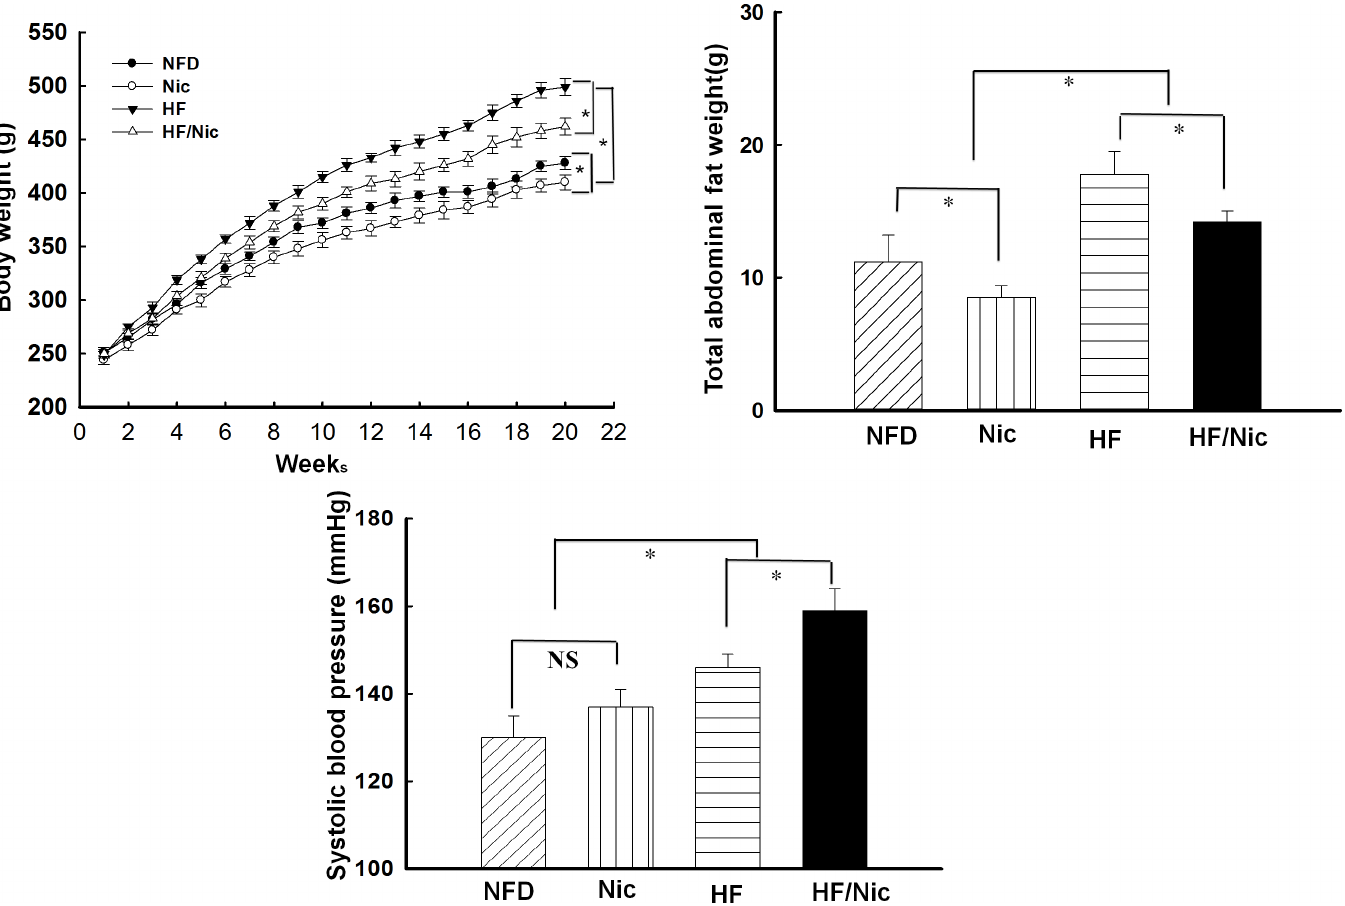
Fig 1. Body weight (A), total abdominal fat weight (B) and systolic blood pressure (SBP, C) in nicotine-treated obese rats. The data was expressed as mean ± SE. NFD: normal rat chow diet; HFD: high fat diet; Nic: NFD with nicotine; HFD/Nic: HFD with nicotinetreatment. N = 6–7, * p < 0.05. https://doi.org/10.1371/journal.pone.0188439.g001 PLOS ONE | https://doi.org/10.1371/journal.pone.0188439 December13,